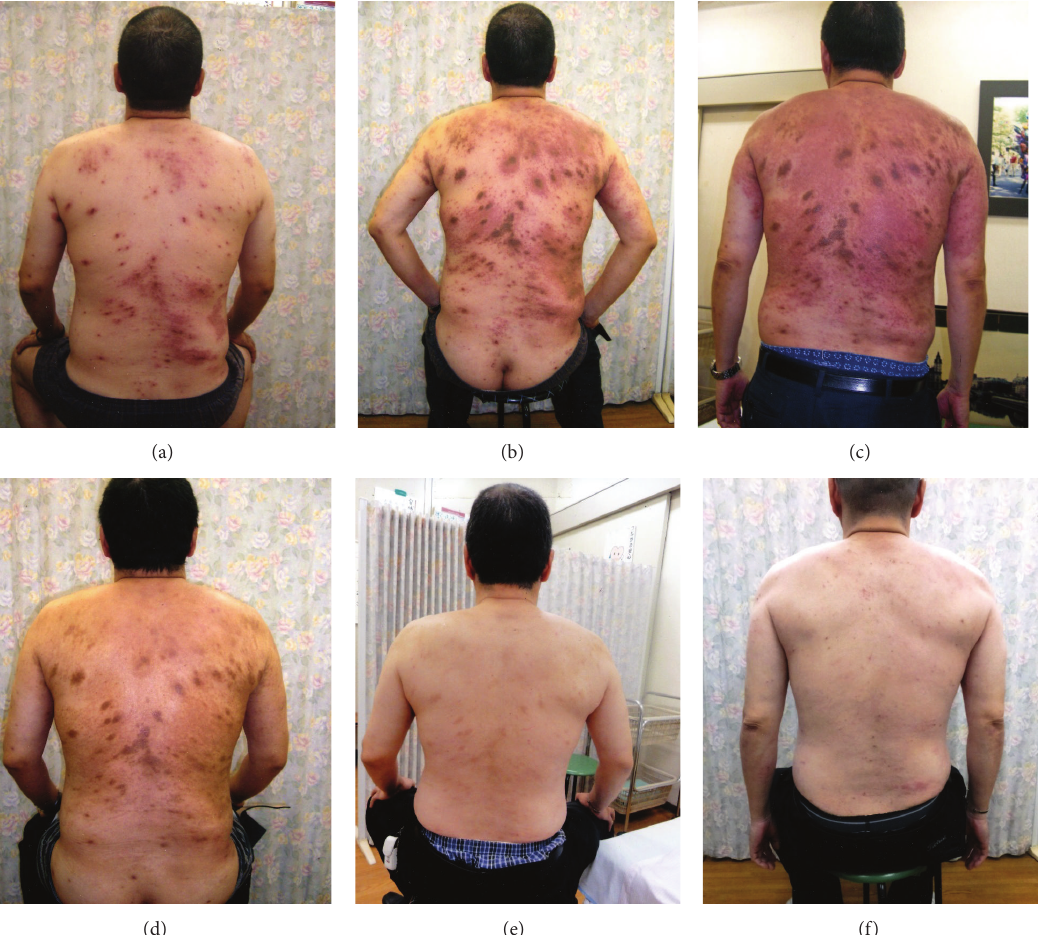
Figure 1: Clinical features of skin rash on the back in case 1 (a 50-year-old male). (a) December 4, 2010 (the first medical inspection), (b) January 12, 2011 (exacerbation), (c) January 26, 2011 (the worst state with erythematous reaction), (d) March 16, 2011 (alleviation), (e) July 17, 2012 (remission), and (f) March 11, 2014 (recurrence). Strict avoidance of the detergent-containing material and usage of cleansing soap without detergents were quite effective to control atopic